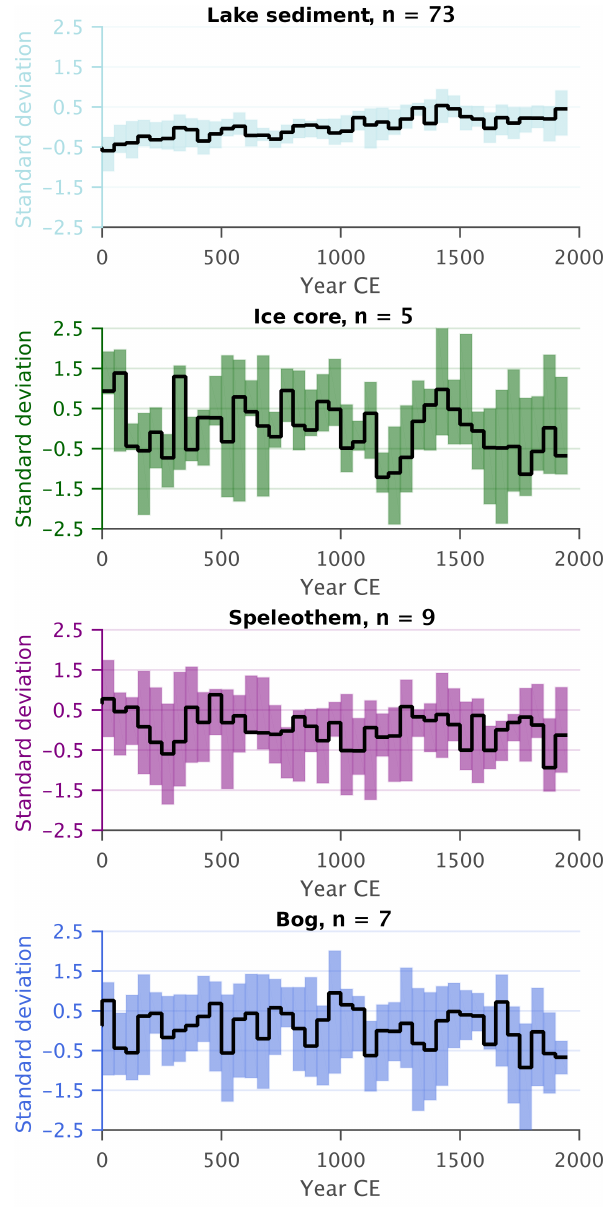
Figure 3. Mean z score time series for each archive type that con- tains more than one